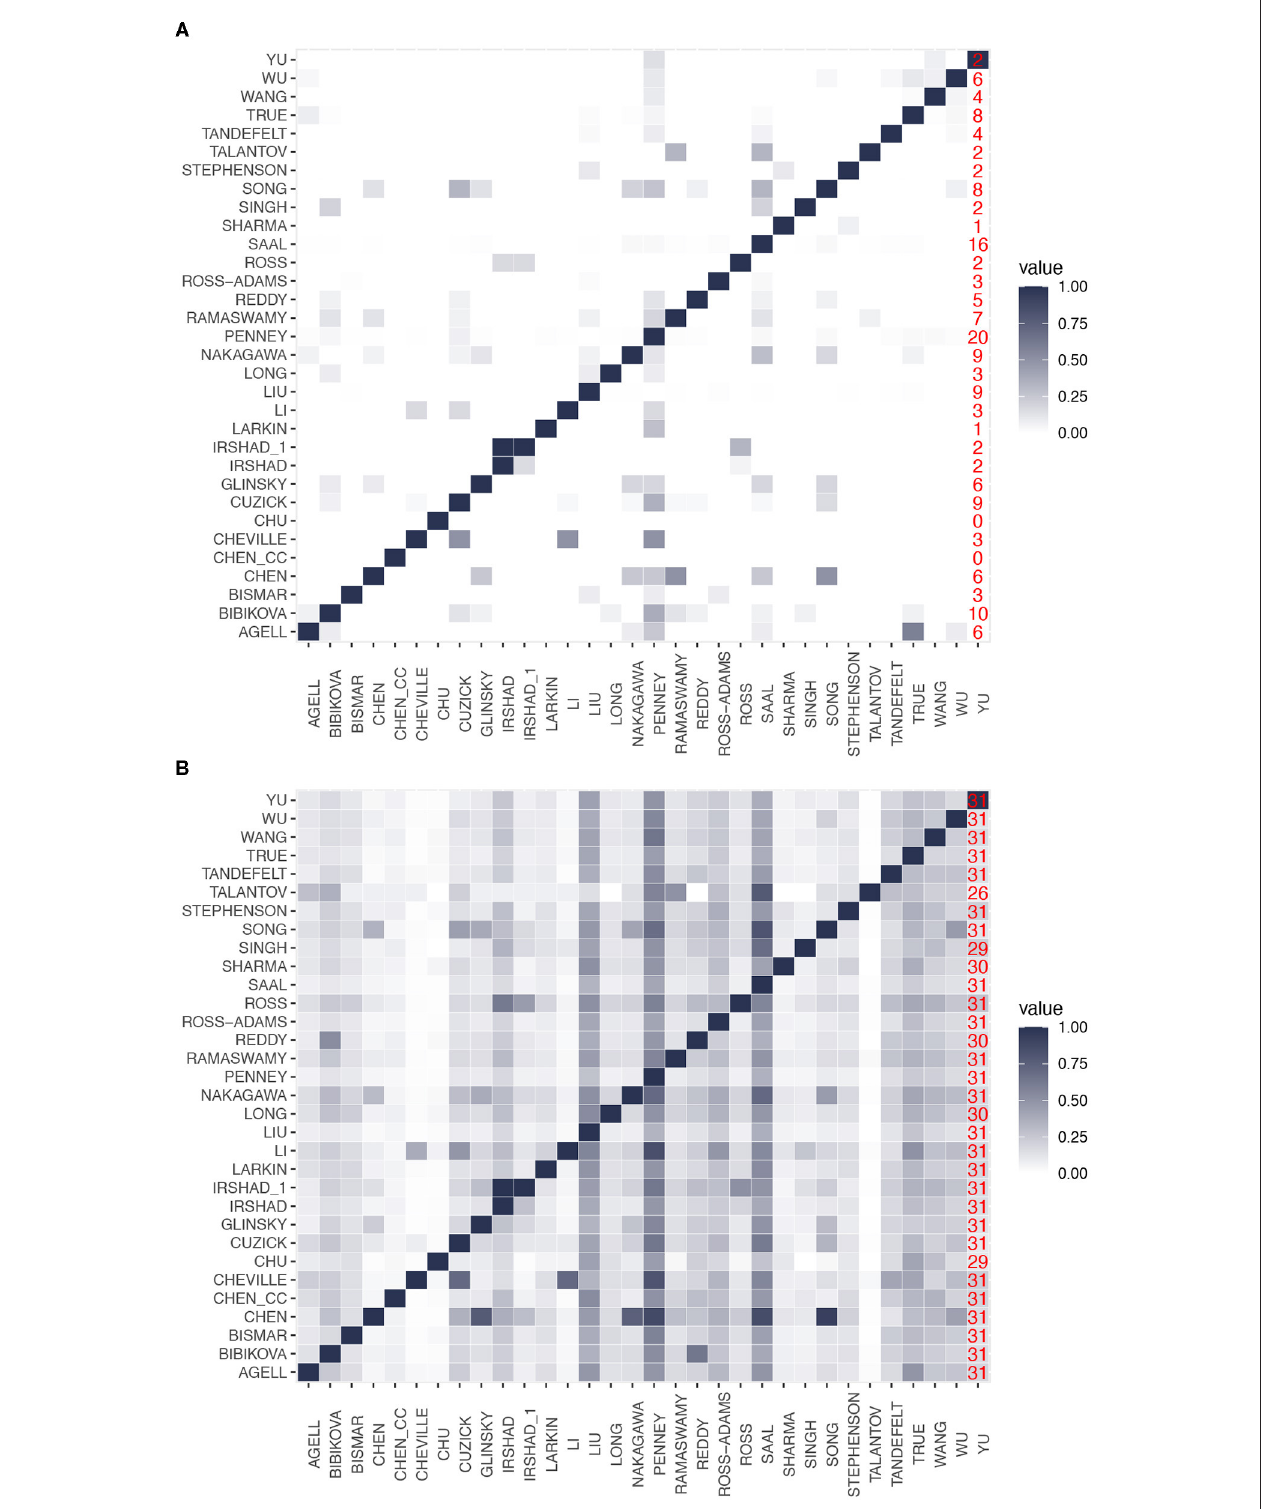
FIGURE 2 | Pairwise overlap between prognostic biomarkers. (A) Overlap in the number of genes. (B) Overlap in the number of gene ontology (GO)-terms. The last column in both heatmaps (red numbers) gives the number of signatures with a non-zero overlap.